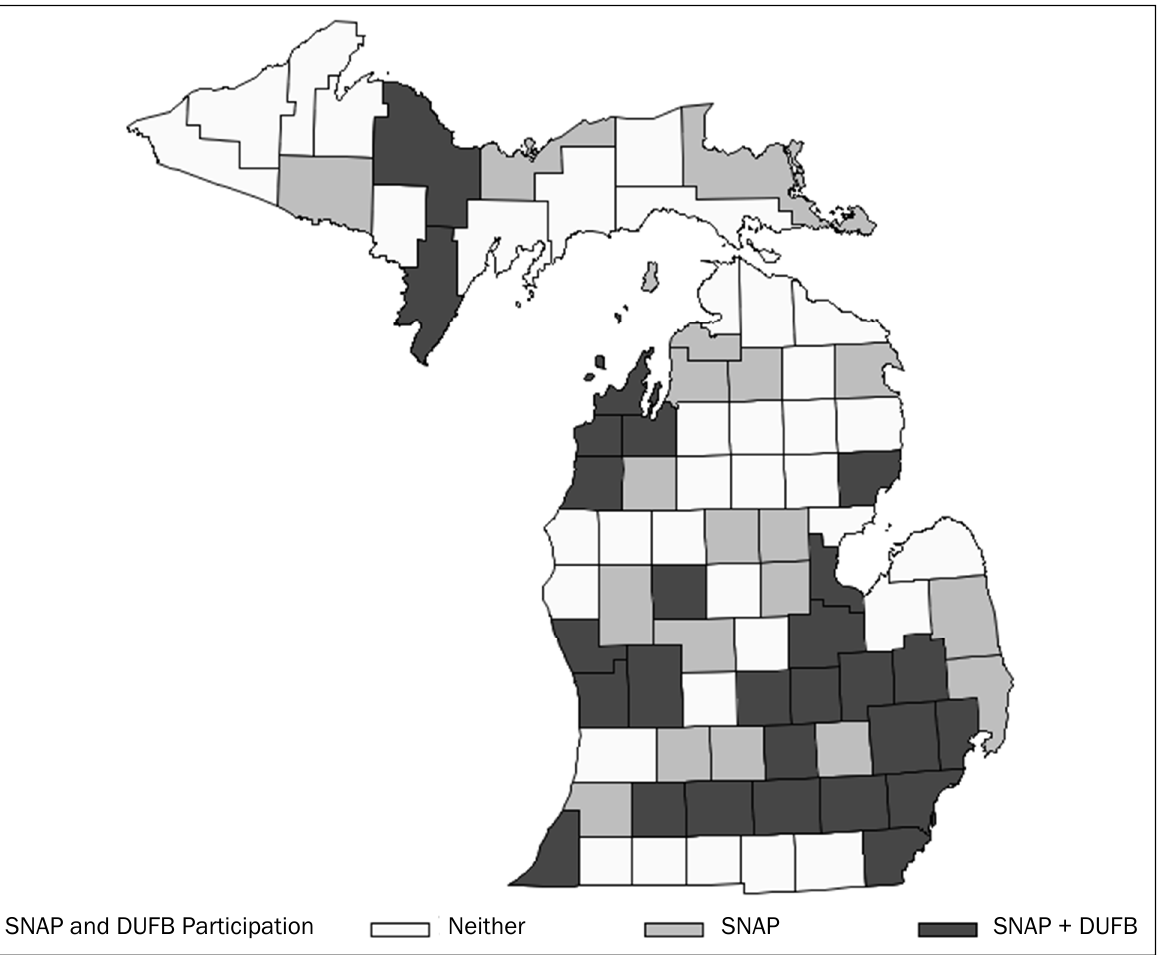
Data sources: USDA ERS (2017) and original data from Fair Food